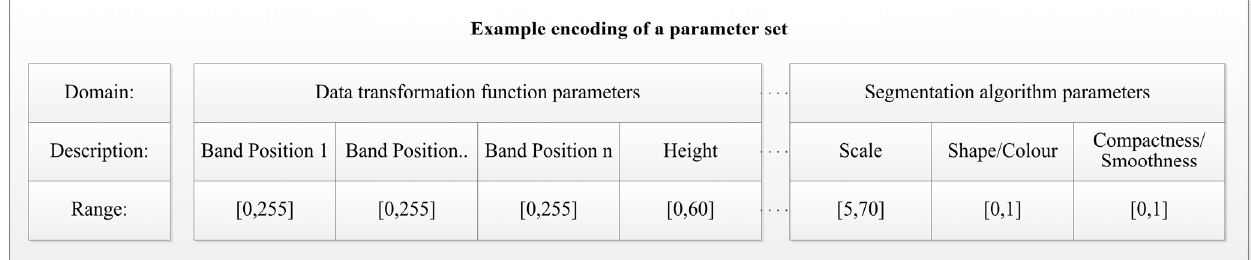
Figure 2. An example encoding of a parameter set traversed by a given search algorithm, highlighting the creation of a joint set from the segmentation algorithm and a low-level image processing